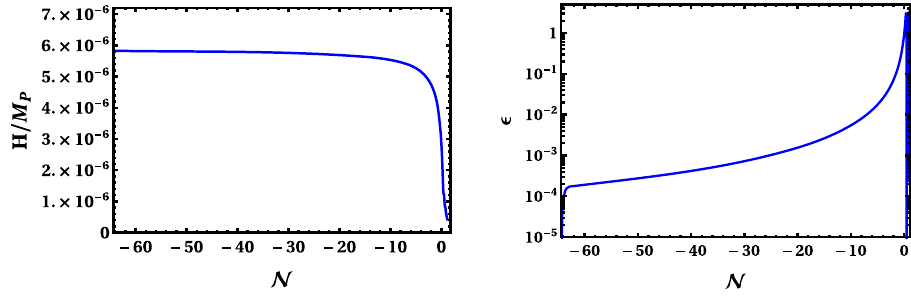
Fig. 3 The evolution of H / M P (left) and (cid:19) (right) with respect